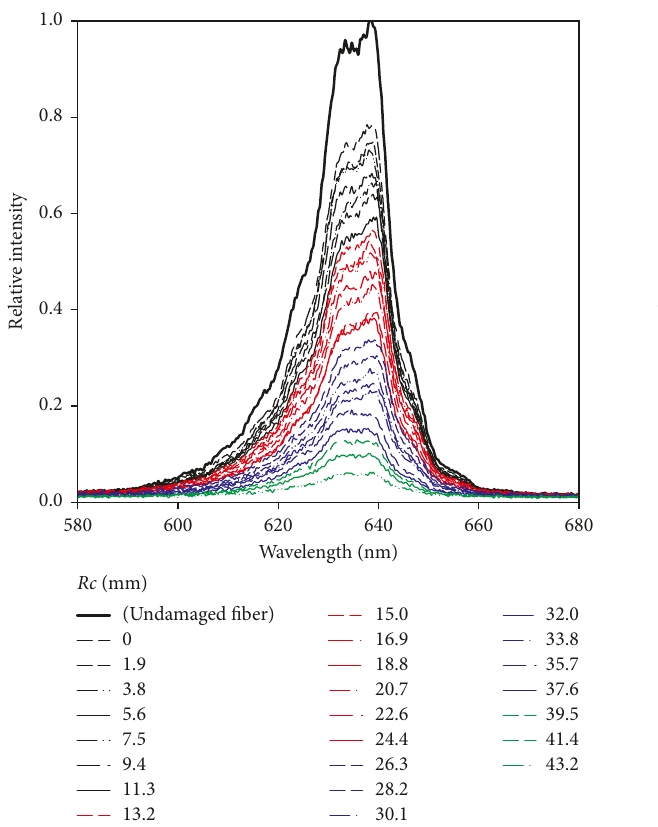
Figure 19: Delivered light intensity at the PGR-FB250 fiber end tip. Figure 20: Delivered light intensity at the PGR-FB750 fiber end